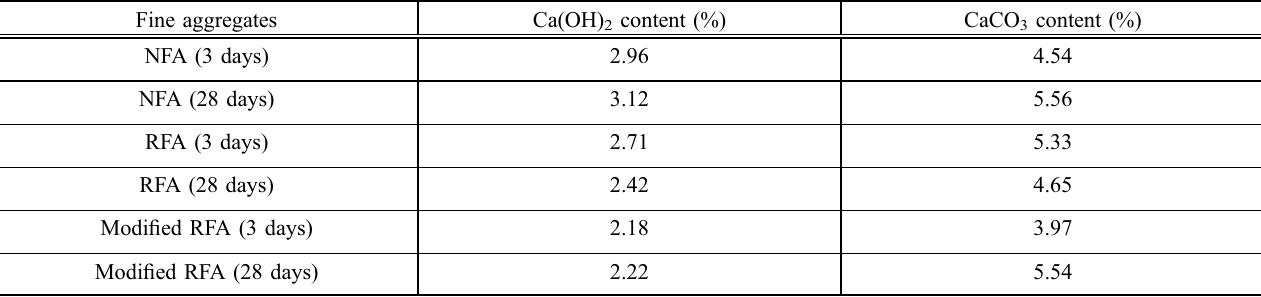
Table 12 Analysis of contents of Ca(OH) 2 and CaCO 3 by the age of